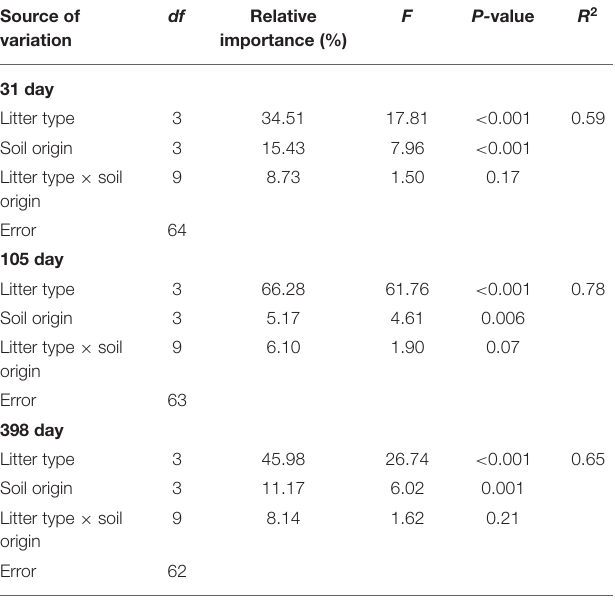
TABLE 4 | Multiple linear regression results from a model with litter mass loss (log-transformed) at 398 day as the dependent variable and litter type, soil inorganic P, total PLFA concentrations, and bacterial richness as independent